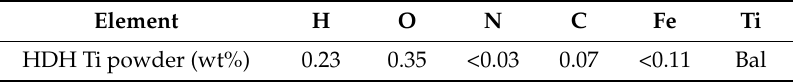
Table 1. Chemical composition of the HDH titanium powders. Element